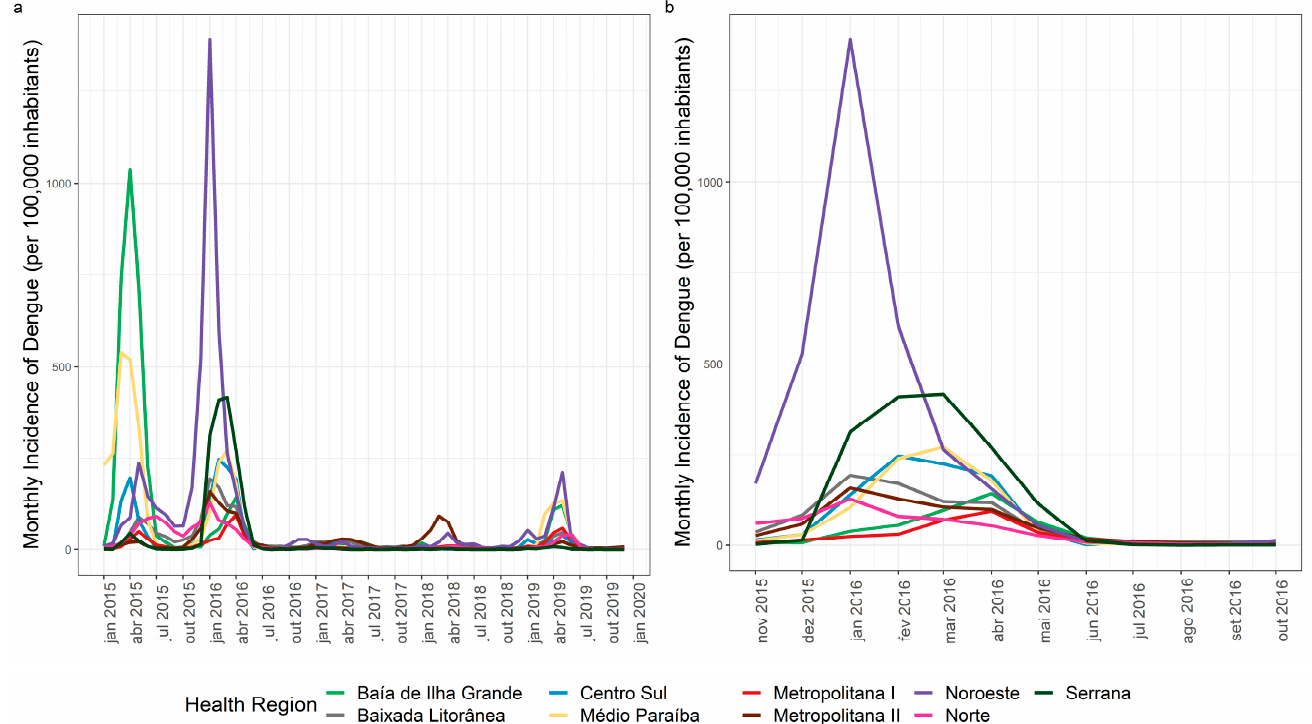
Figure 4. ( a ) Dengue by month/year of symptom onset in Rio de Janeiro state, 2015–2019. ( b ) Dengue by month/year of symptom onset in Rio de Janeiro state, November 2015–October 2016.